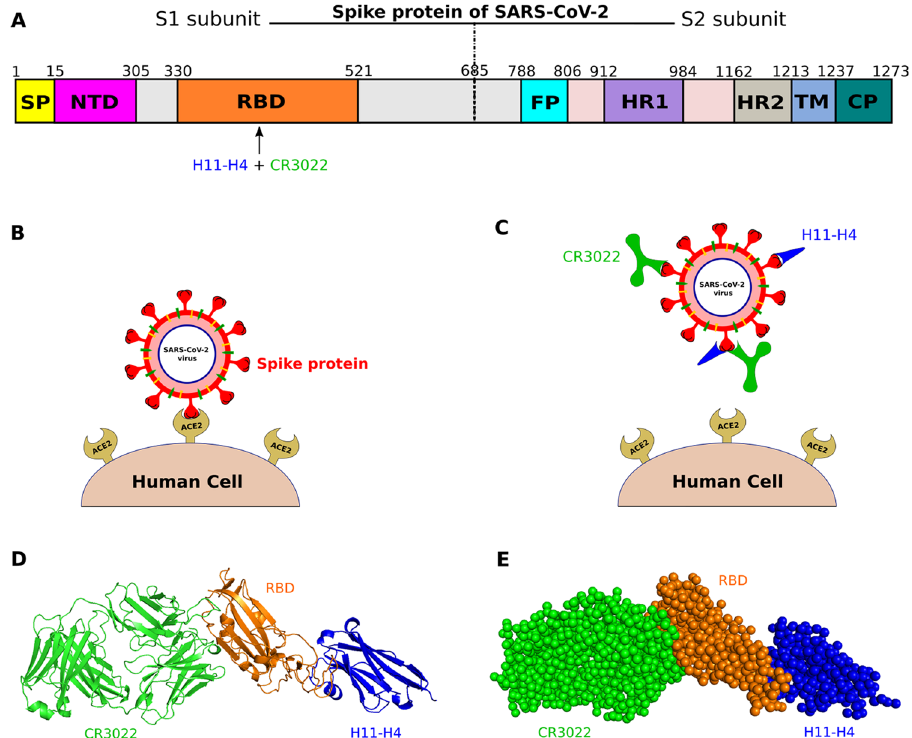
Figure 1. ( A ) Schematic description of the S protein of SARS-CoV-2, which consists of the S1 and S2 subunits. ( B ) SARS-CoV-2 S protein binds to human ACE2 before entering cells. ( C ) H11-H4 and CR3022 bind to S protein, preventing the virus from entering cells. The 3D structures of H11-H4 and CR3022 bound to RBD are shown in all-atom ( D ) and coarse-grained ( E ) models.